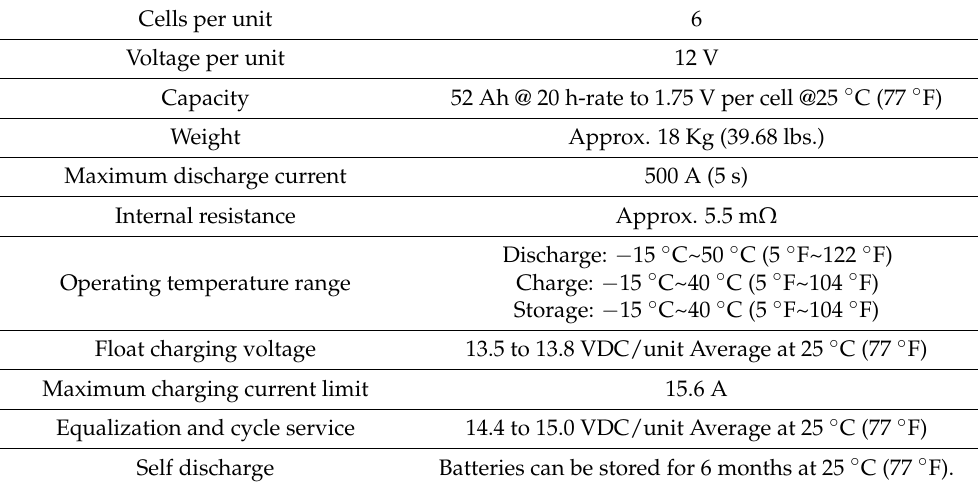
Table 3. Lead–acid battery parameters.